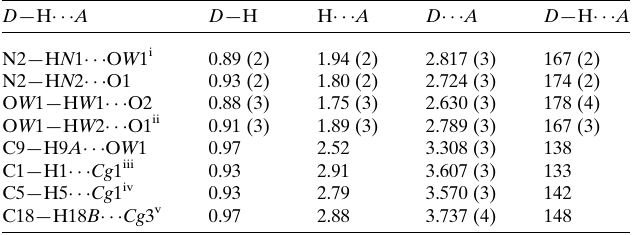
Table 1 Hydrogen-bond geometry (A˚ , (cid:3) ) for ( I ). Cg 1 and Cg 3 are the centroids of the C12–C17 and C1–C6 benzene rings,